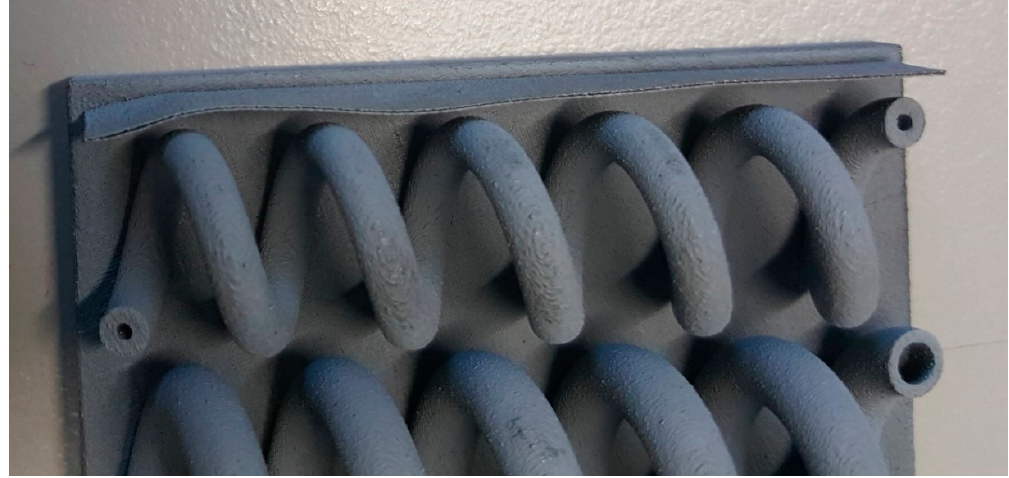
Figure 16. Picture of the real sample from company C, first job, BL.